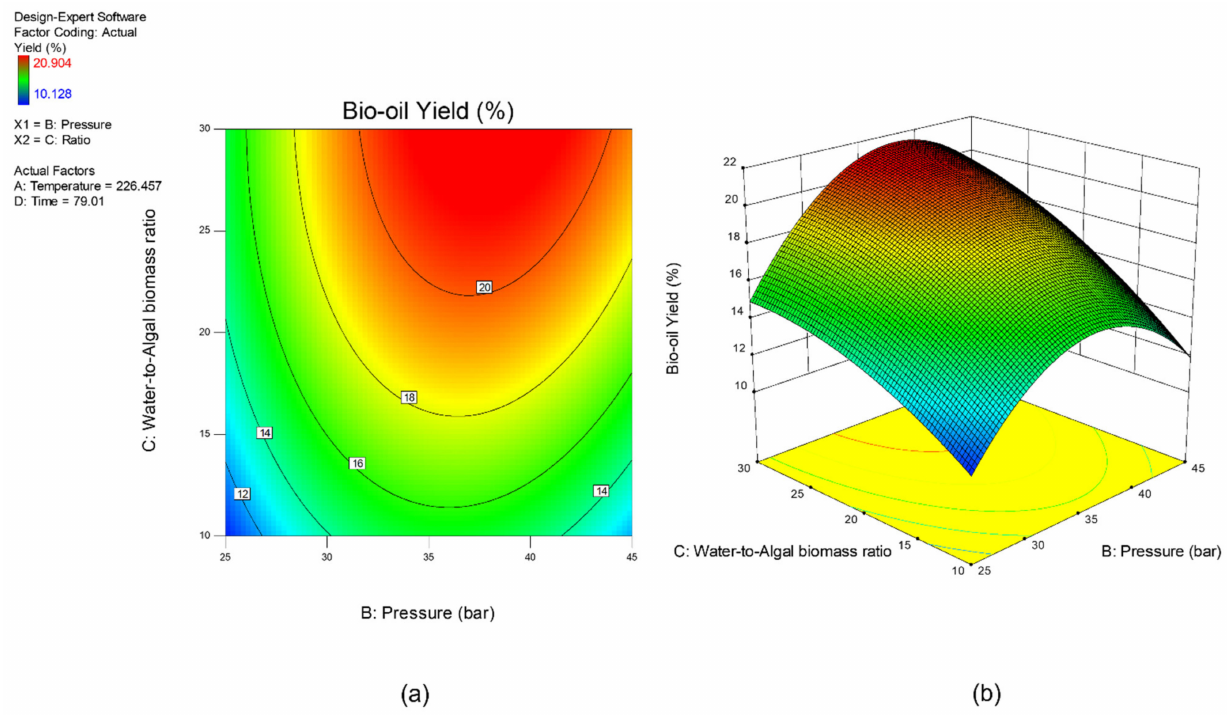
Figure 8. ( a ) Contour plot, and ( b ) 3-dimensional plot for response, bio-oil